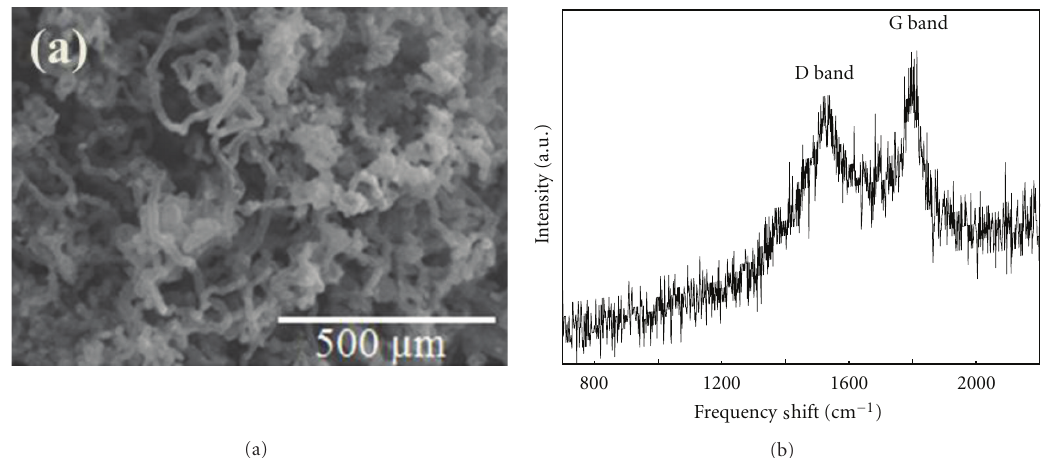
Figure 2: SEM image (a) and Raman spectrum (b) of Pd/CNTs/CoMoO 4 /silica catalysts.